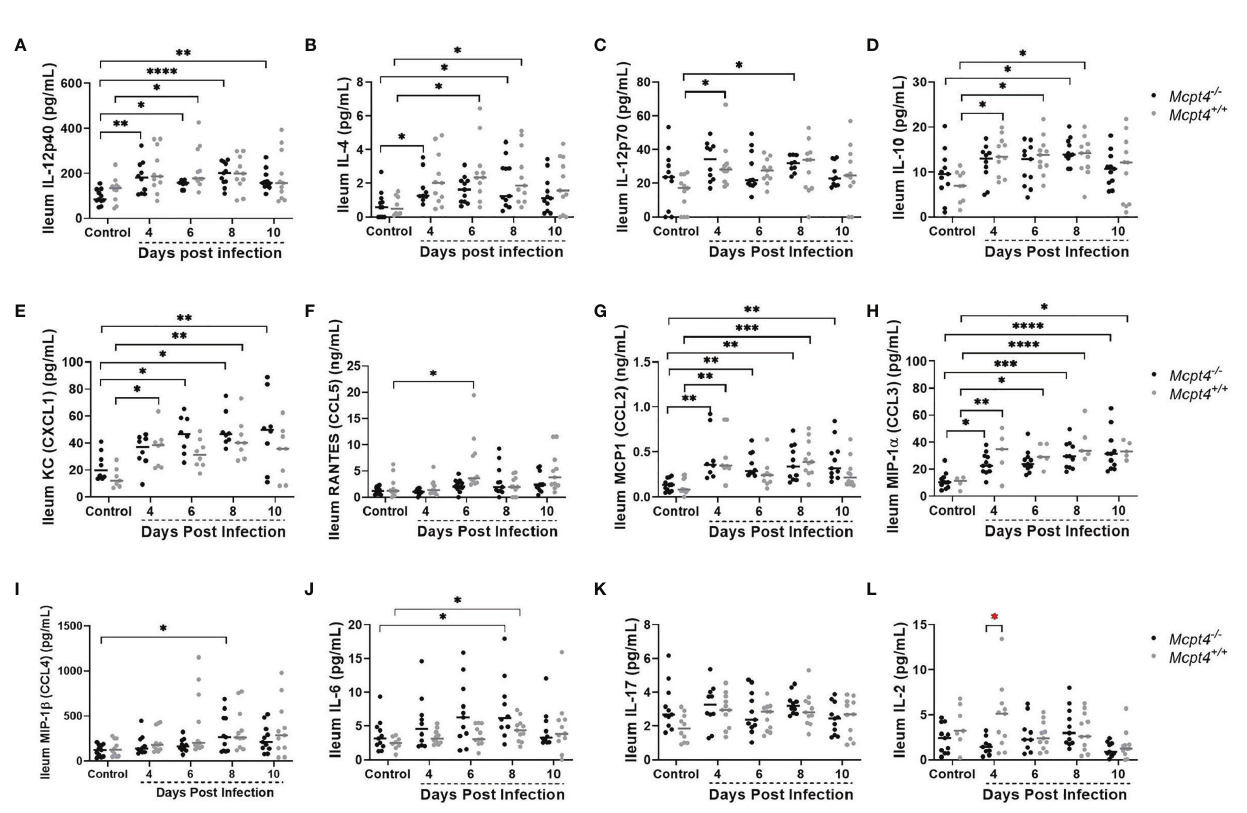
FIGURE 6 | Ileal cytokines and chemokines in P. y. yoelii 17XNL-infected Mcpt4 -/- and Mcpt4 +/+ mice and uninfected controls. (A – L) The x axis represents the time points in days after infection, and the y axis represents the concentrations of IL-12p40 (A) , IL-4 (B) , IL-12p40 (C) , IL-10 (D) , KC (CXCL1) (E) , RANTES (CCL5) (F) , MCP- 1 (CCL2) (G) , MIP1 a (CCL3) (H) , MIP1 b (CCL4) (I) , IL-6 (J) , IL-17 (K) and IL-2 (L) . Each dot represents a single mouse. Cytokines levels in ileum were determined for the three biological replicates (n=11 mice per group per time point). Data were analyzed with the Kruskal-Wallis test followed by Dunn ’ s multiple comparison for each time point versus control or between Mcpt4 -/- and Mcpt4 +/+ mice at speci fi c time points. P values ≤ 0.05 were considered signi fi cant. *P ≤ 0.05, **P ≤ 0.01, ***P ≤ 0.001, ****P ≤